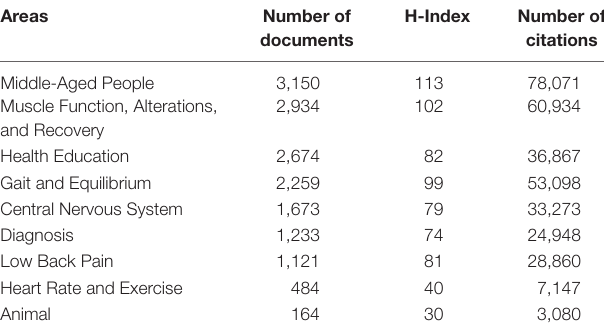
Table 4 | Performance values for the Physical Therapy thematic areas.